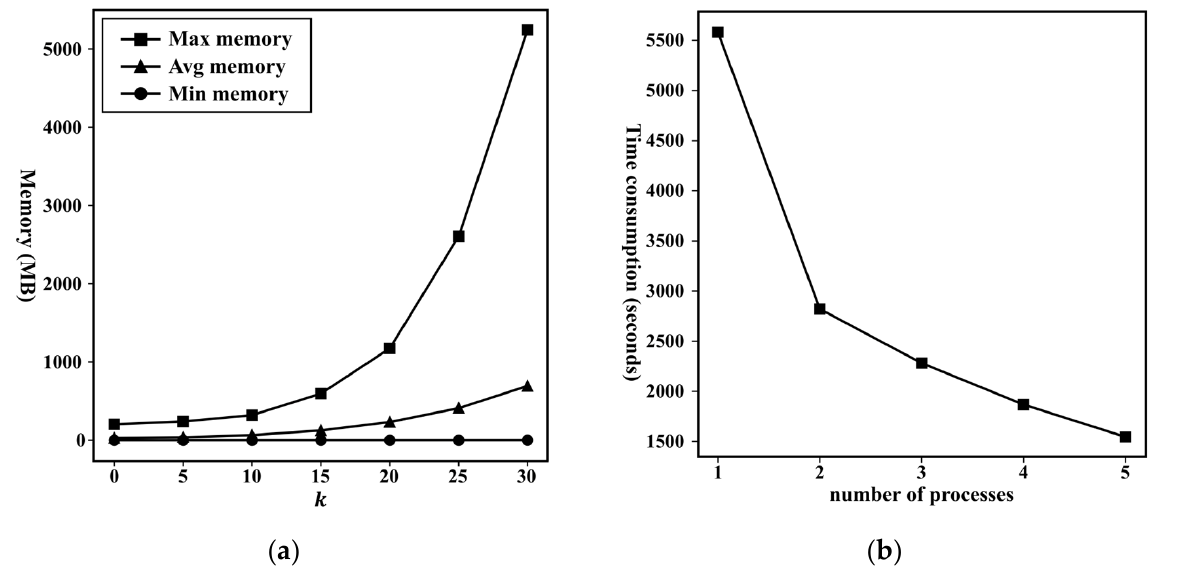
Figure 6. Illustration of: ( a ) the memory usage efficiency; ( b ) random walk calculation efficiency of the proposed framework.